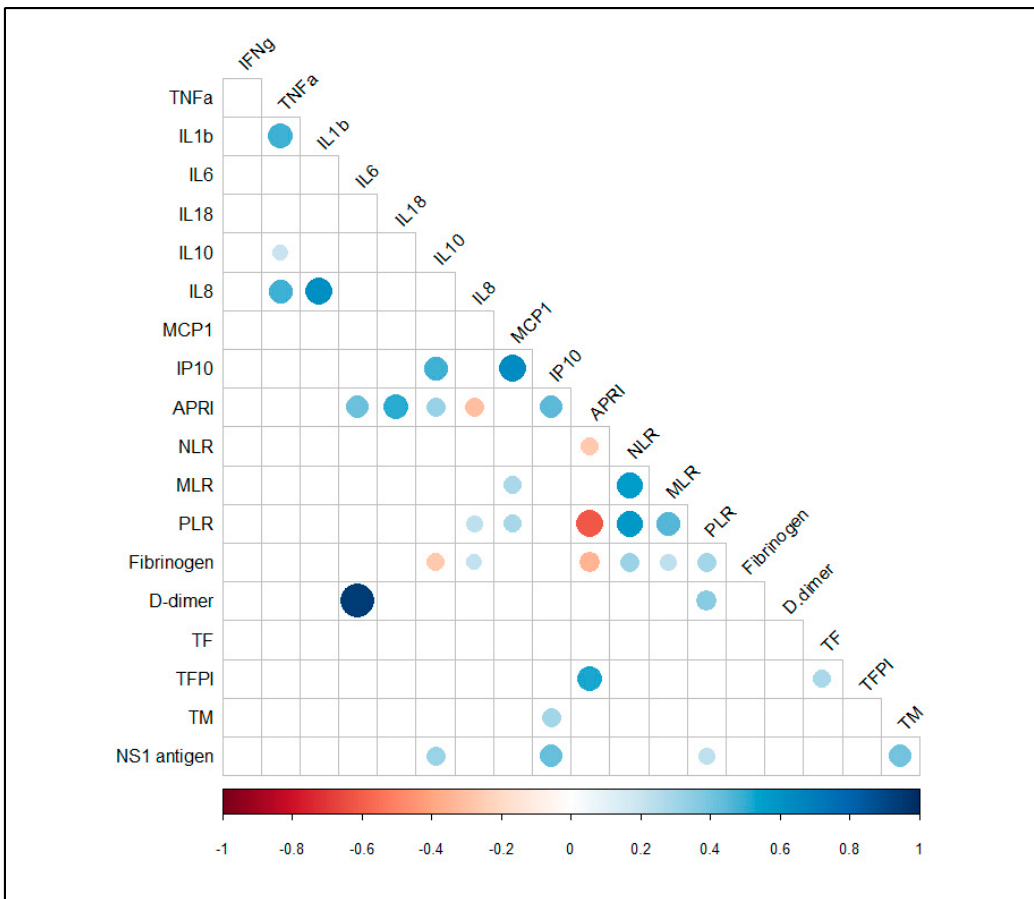
Figure 1. Spearman correlation correlogram between cytokines/chemokines, coagulation parameters and other biomarkers of confirmed cases of dengue. The strength of the correlation between two variables is represented by the color of the circle (only shown if p value < 0.05). Colors range from bright blue (strong positive correlation; r s = 1.0) to bright red (strong negative correlation; r s = − 1.0).